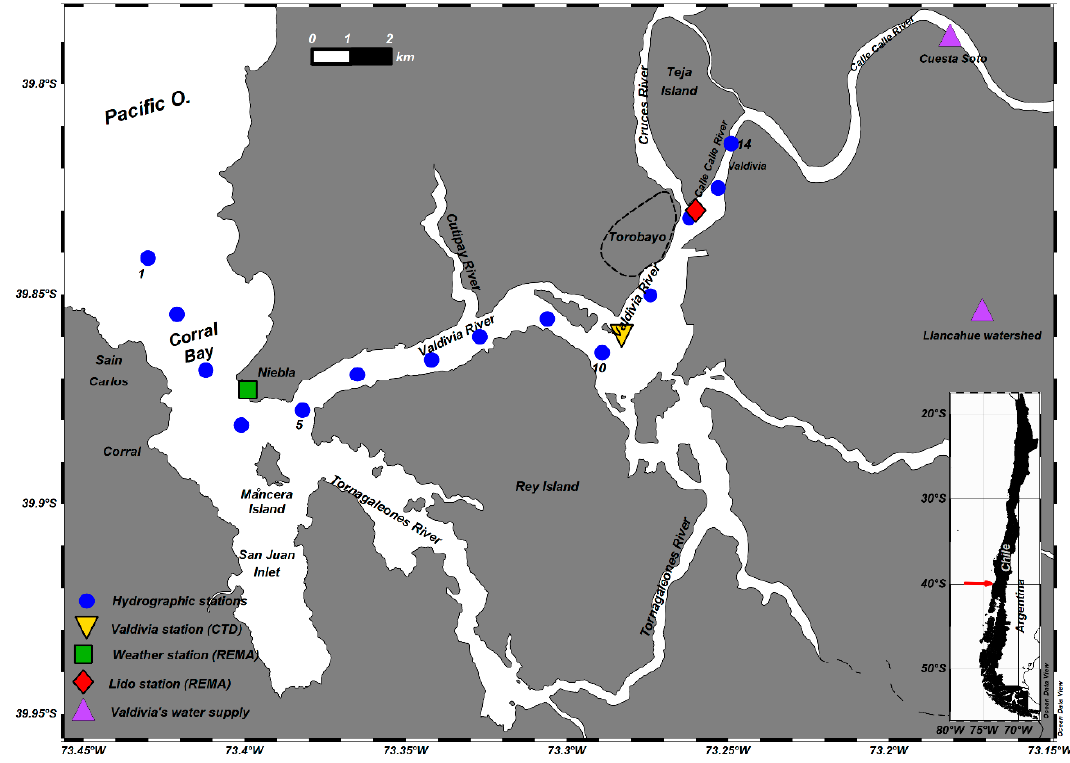
Figure 1. Map of the Valdivia River estuary (VRE). Right inset shows location of study area.